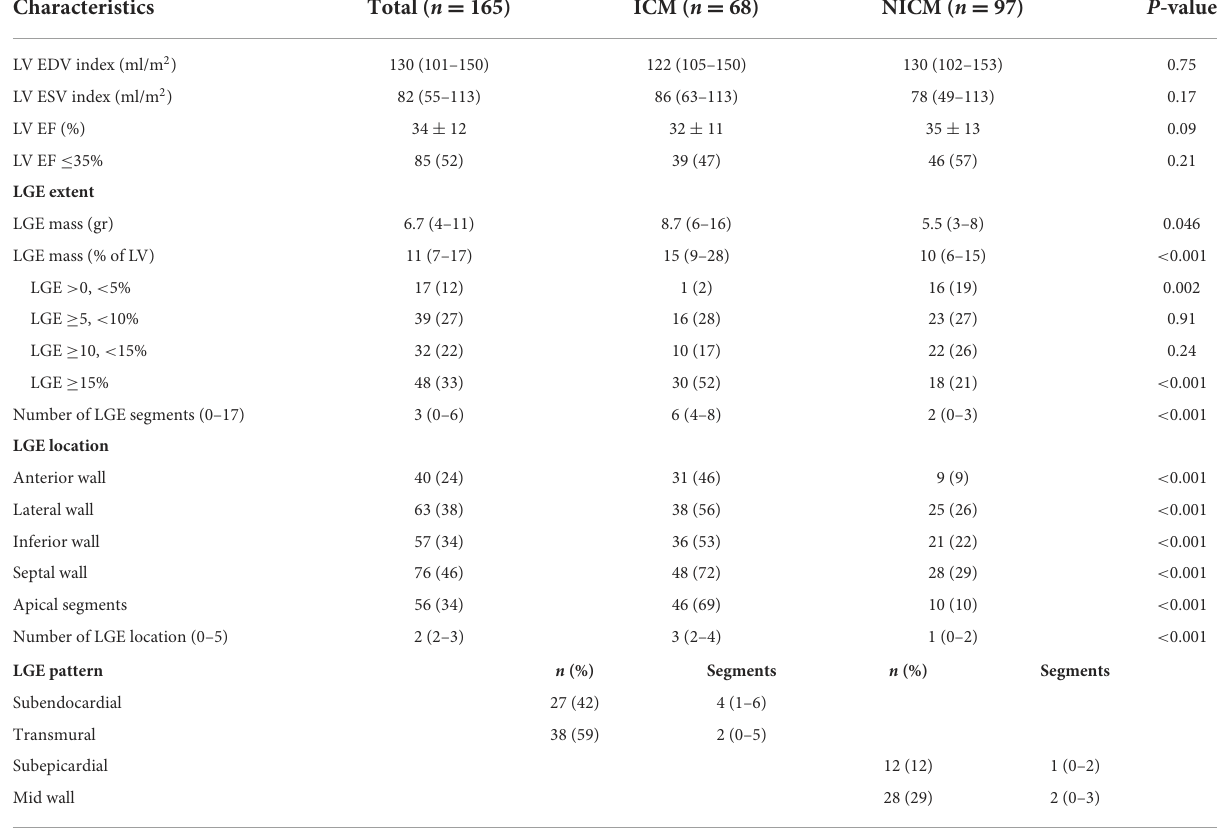
TABLE 2 CMR characteristics of the